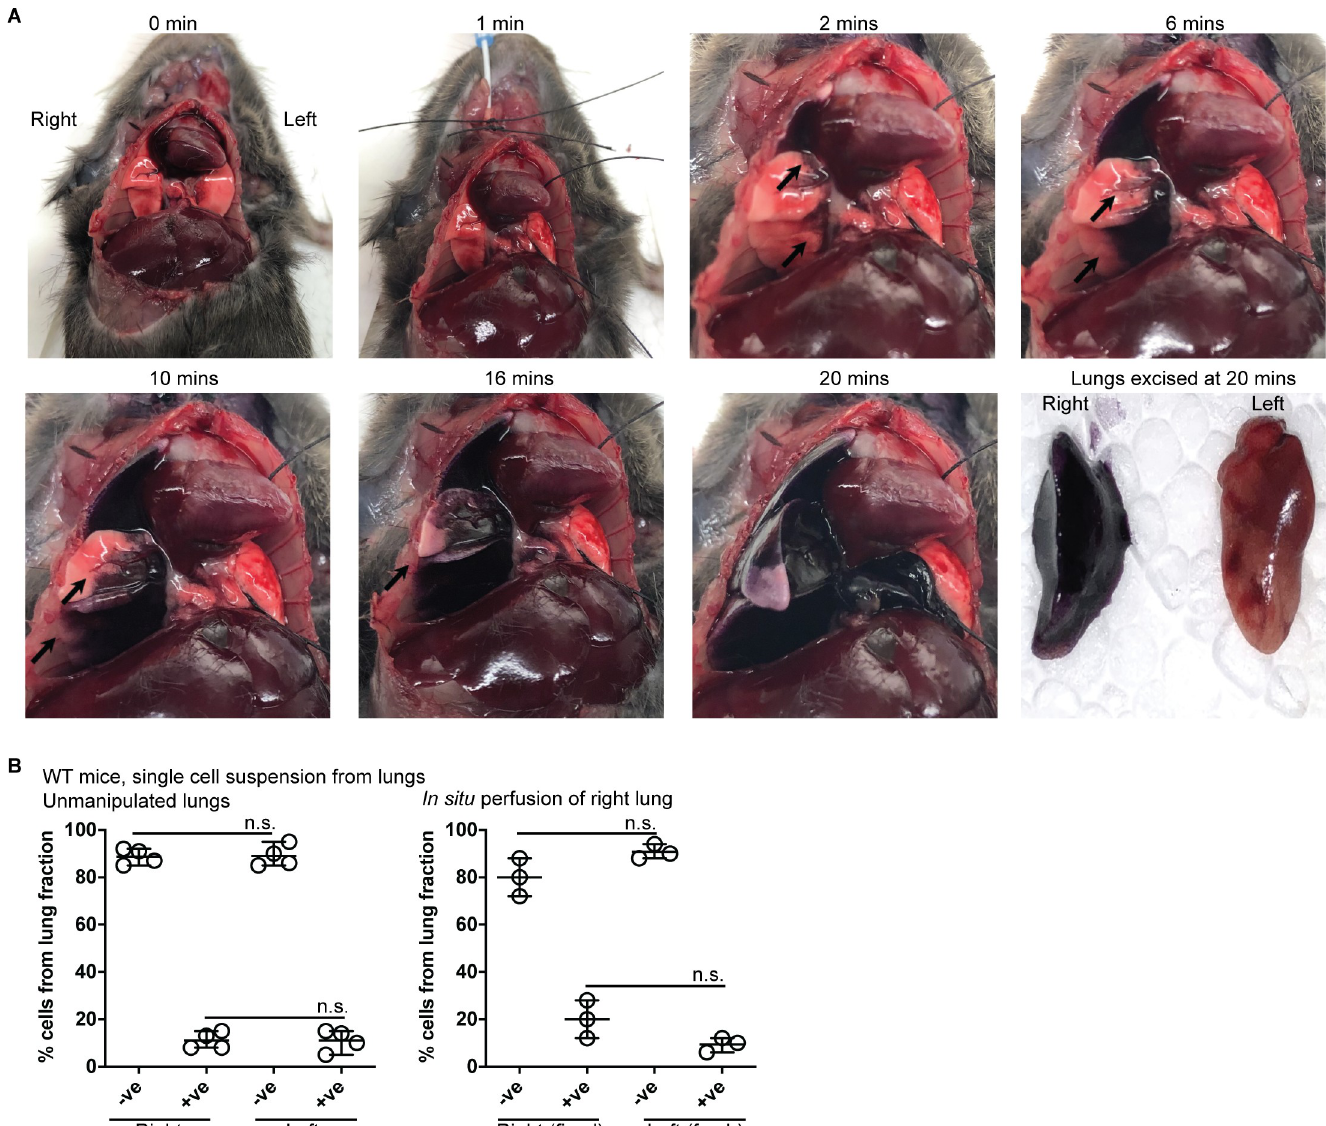
Fig 2. Fluid flow to right lung and occlusion of the left lung. (A) Hematoxylin dye was introduced to the right lung using in situ perfusion technique described in Fig 1. Pictures are from the same mouse (representative of three) depicting dye incorporation in the right lung over 0 through 20 minutes. By 20 minutes right lung turns dark blue while left lung does not show any visible dye. (B) Single cell suspensions obtained from the left lungs of uninfected mice were treated with typan blue for assessment of viability. Trypan blue negative (-ve) cells retain membrane property indicating viability, whereas positive (+ve) cells have membrane integrity damaged indicating loss of viability. Each data point represents one mouse with 3–4 mice per group. Error bars show mean error and range. Statistical analyses between groups were performed using unpaired t-test with Welch’s correction. n.s. is non-significant.